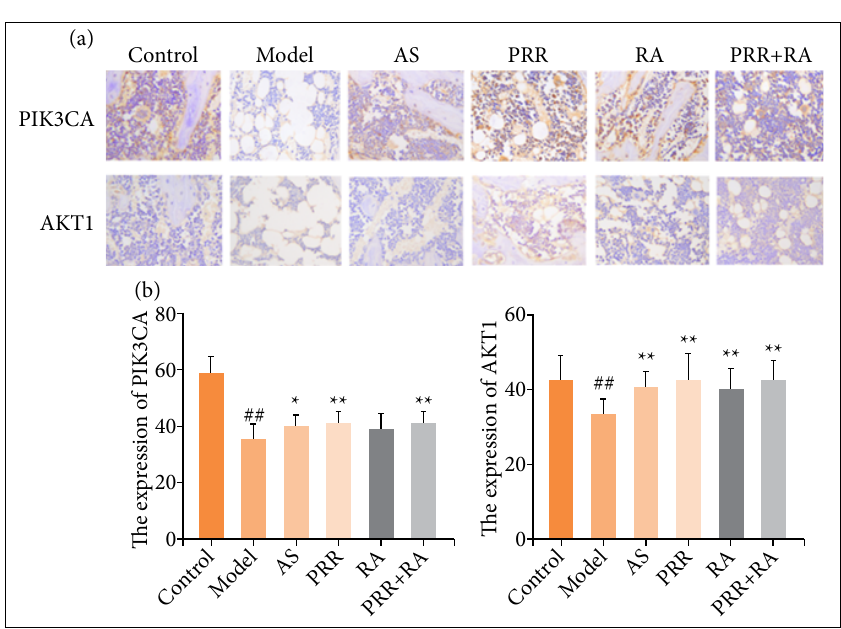
Figure 3 - (a) Expression levels of PIK3CA and Akt1 in rat bone tissue (× 200); (b) changes of PIK3CA and Akt1 expression levels in rat bone tissue # .